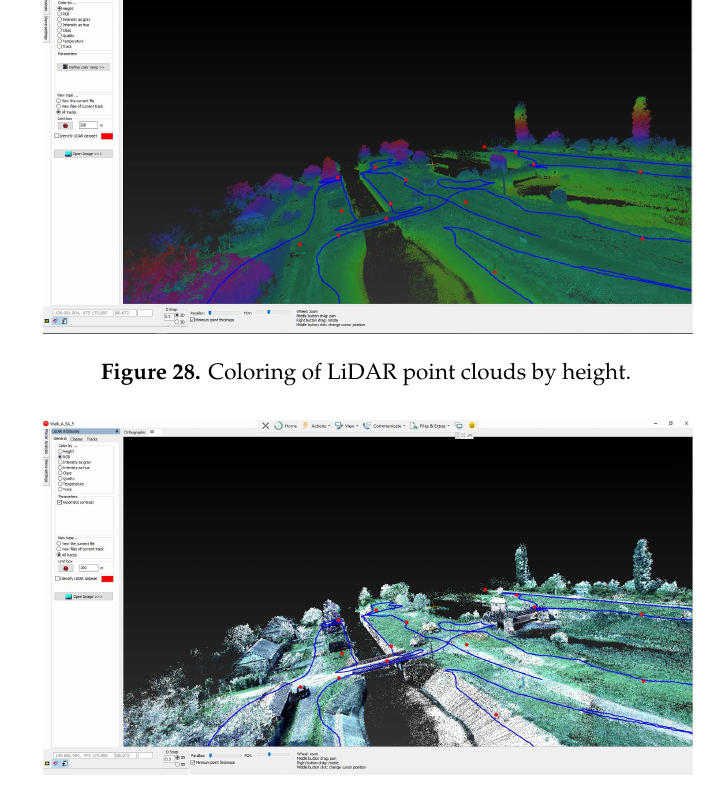
Figure 29. RGB coloring of LiDAR point clouds.